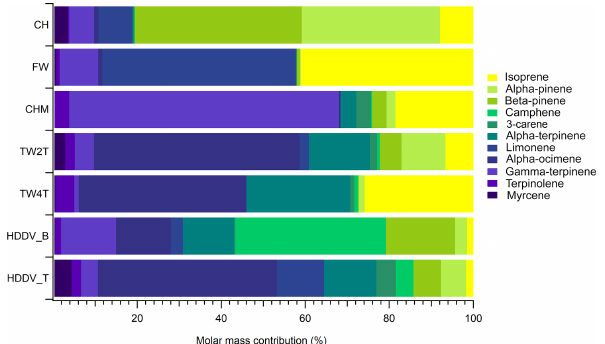
Figure 11. Distribution of monoterpenes and isoprene in the emis- sion sources measured in Abidjan. The values represent the percent- age of each terpenoid over the total emission estimated for these